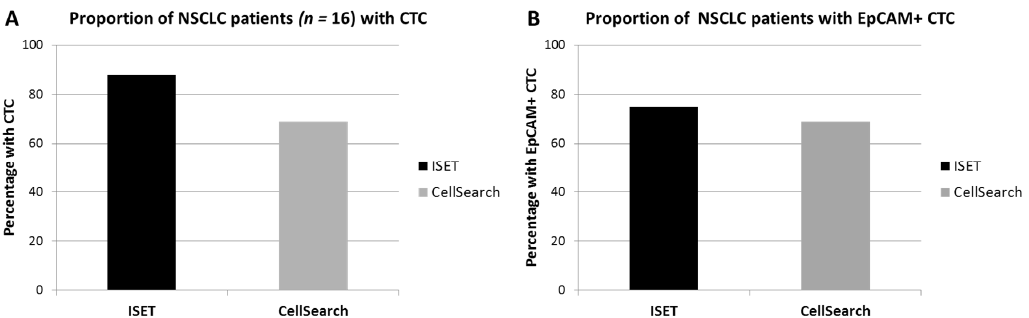
Figure 1. Percentage of diagnostic apheresis products with circulating tumor cells (CTCs) detected by Isolation by SizE of Tumor cells (ISET) or CellSearch. The proportion of patients with CTCs (defined as either expressing TTF1/p40 or EpCAM, while lacking CD45) ( A ), and the proportion of patients with CTCs expressing the epithelial cell adhesion molecule (EpCAM) ( B ) have been shown.